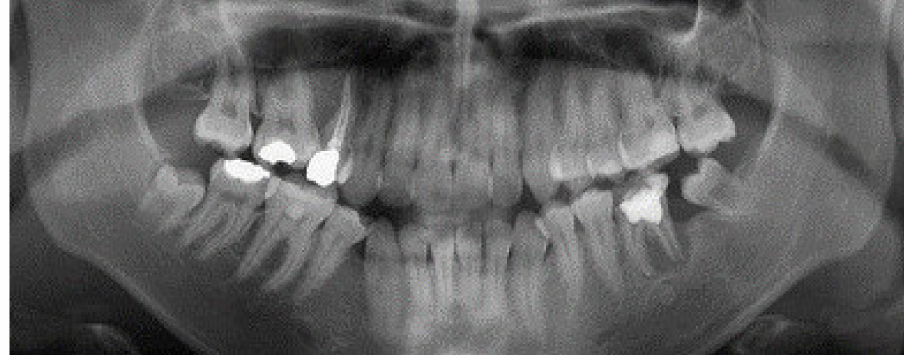
Figure 1. The radiographic evaluation showed severe bone loss in the distal root area of the hopeless tooth #19.